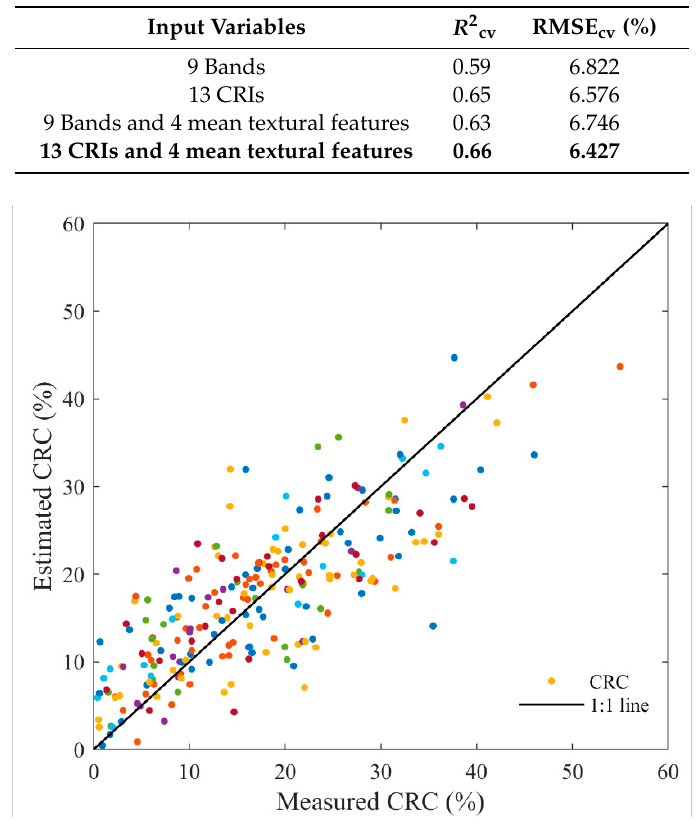
Table 4. The performances of partial least squares regression (PLSR) associated with four groups of input predictors on CRC estimation. The best-performing input variable combination is highlighted in boldface.